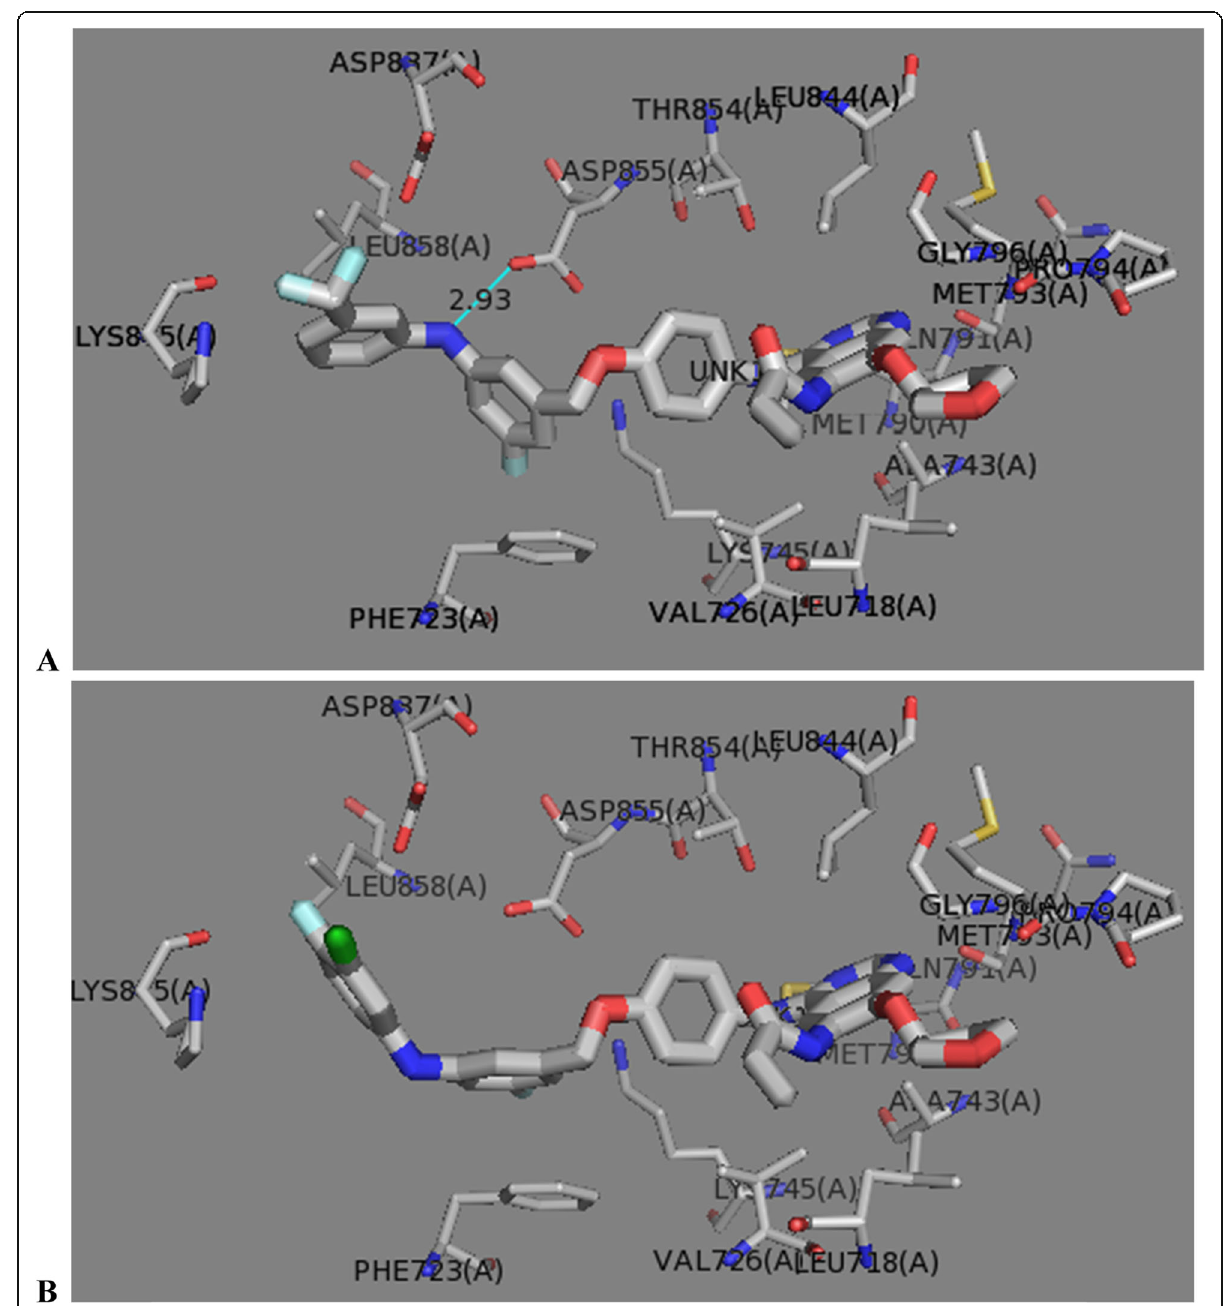
Fig. 4 2D structures of the designed compound a SED 10 and b SED 14 in complex with EGFR enzyme using discovery